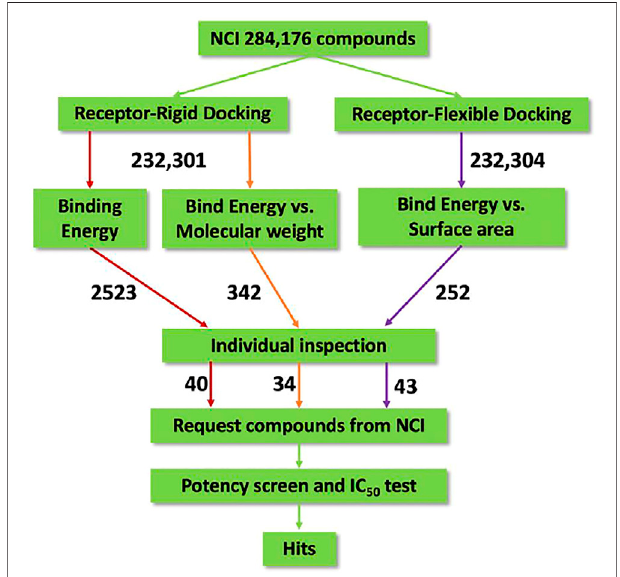
FIGURE 1 | Flow diagram of the integrated virtual screen strategy. The diagram includes data preparation, docking methods, post-docking fi ltering, individual inspection, and in vitro potency test. The arrow is labeled with the number of compounds fl owing along the respective colored path for assessment.